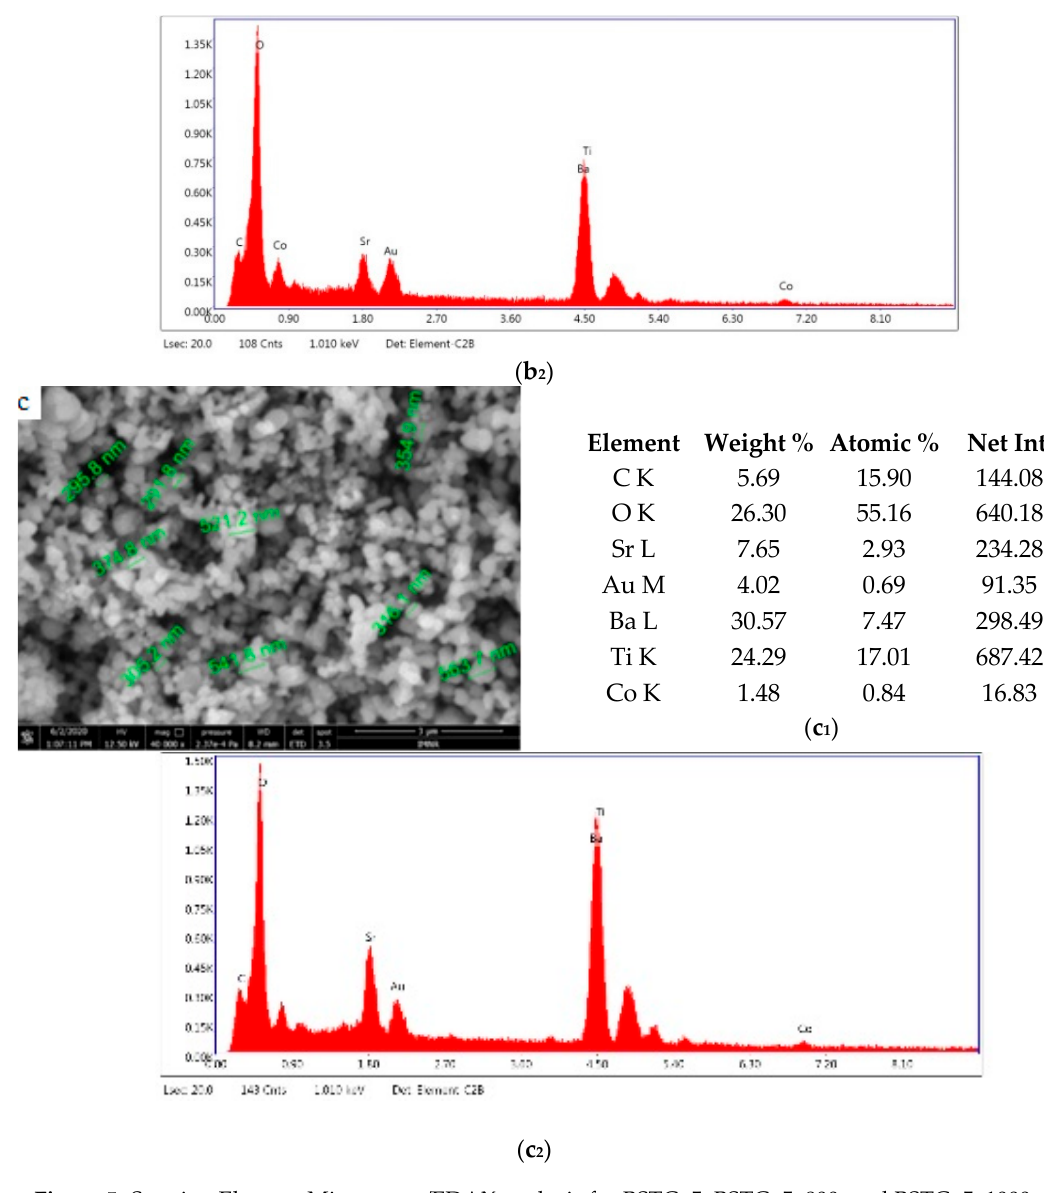
Figure 5. Sanning Electron Microscopy/EDAX analysis for BSTCo5, BSTCo5_800, and BSTCo5_1000: ( a–c ) Scanning Electron Microscopy for BSTCo5, BSTCo5_800, and BSTCo5_1000; ( a 1 –c 1 ) tables of EDAX elemental content for BSTCo5, BSTCo5_800, and BSTCo5_1000; (a 2 –c 2 ) EDAX mapping for BSTCo5, BSTCo5_800, and BSTCo5_1000.